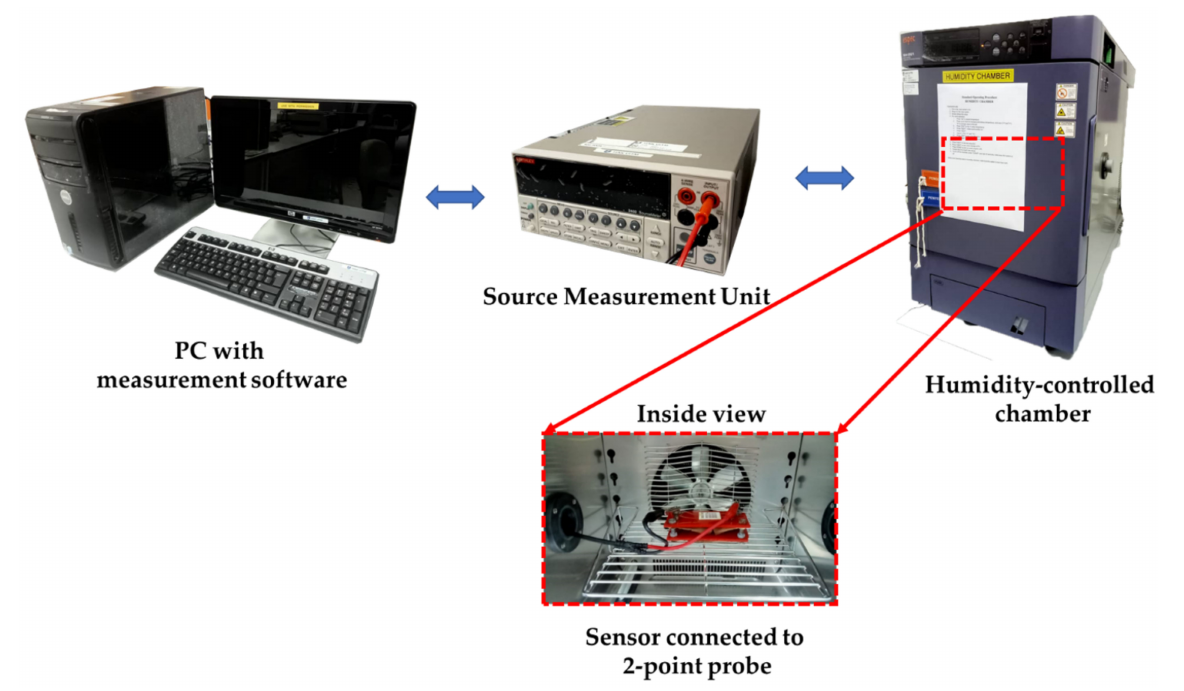
Figure 2. Schematic diagram of the humidity sensor measurement